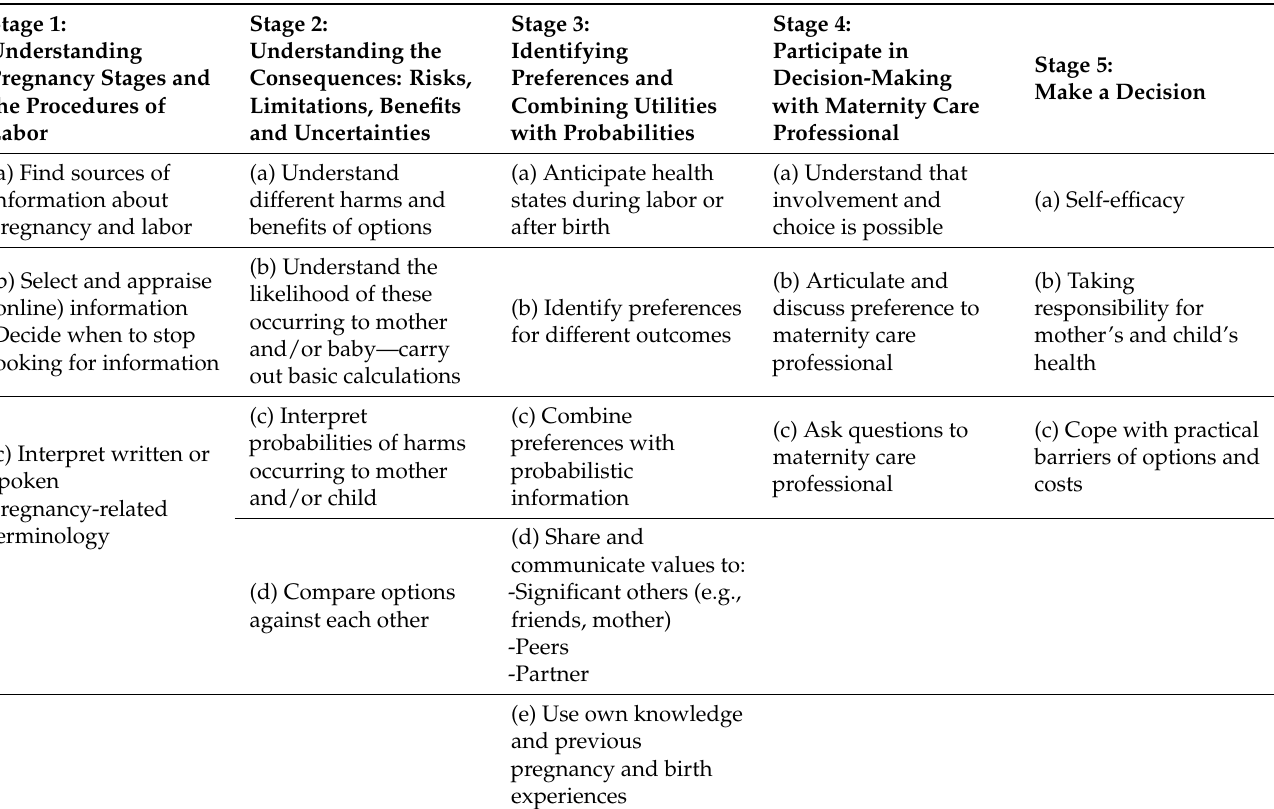
Table 2. Decision-making stages and health literacy skills in maternity